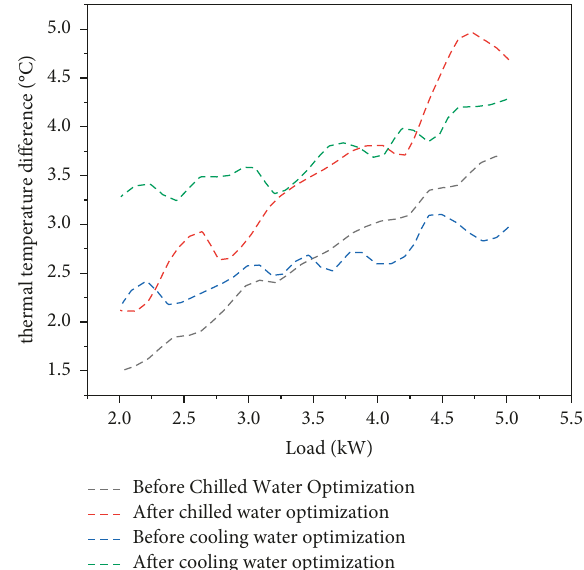
Figure 14: Temperature difference between chilled water and cooling water before and after genetic algorithm optimization.